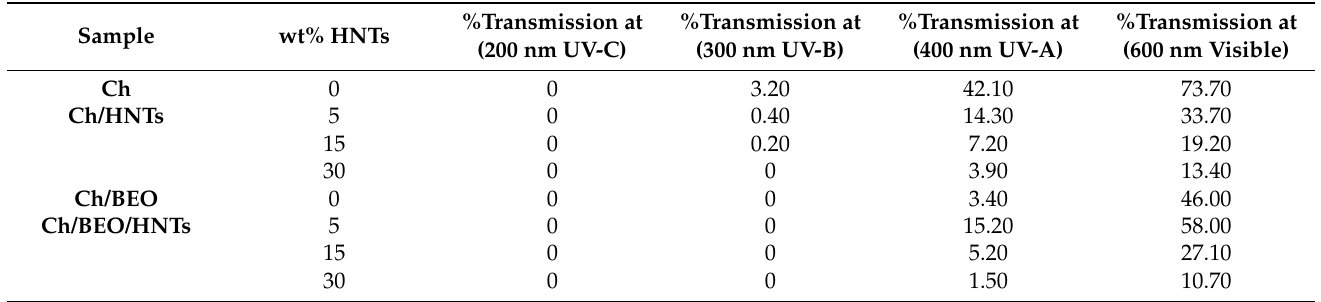
Table 1. Light transmission values of Ch film synthesized with the HNTs and BEO were